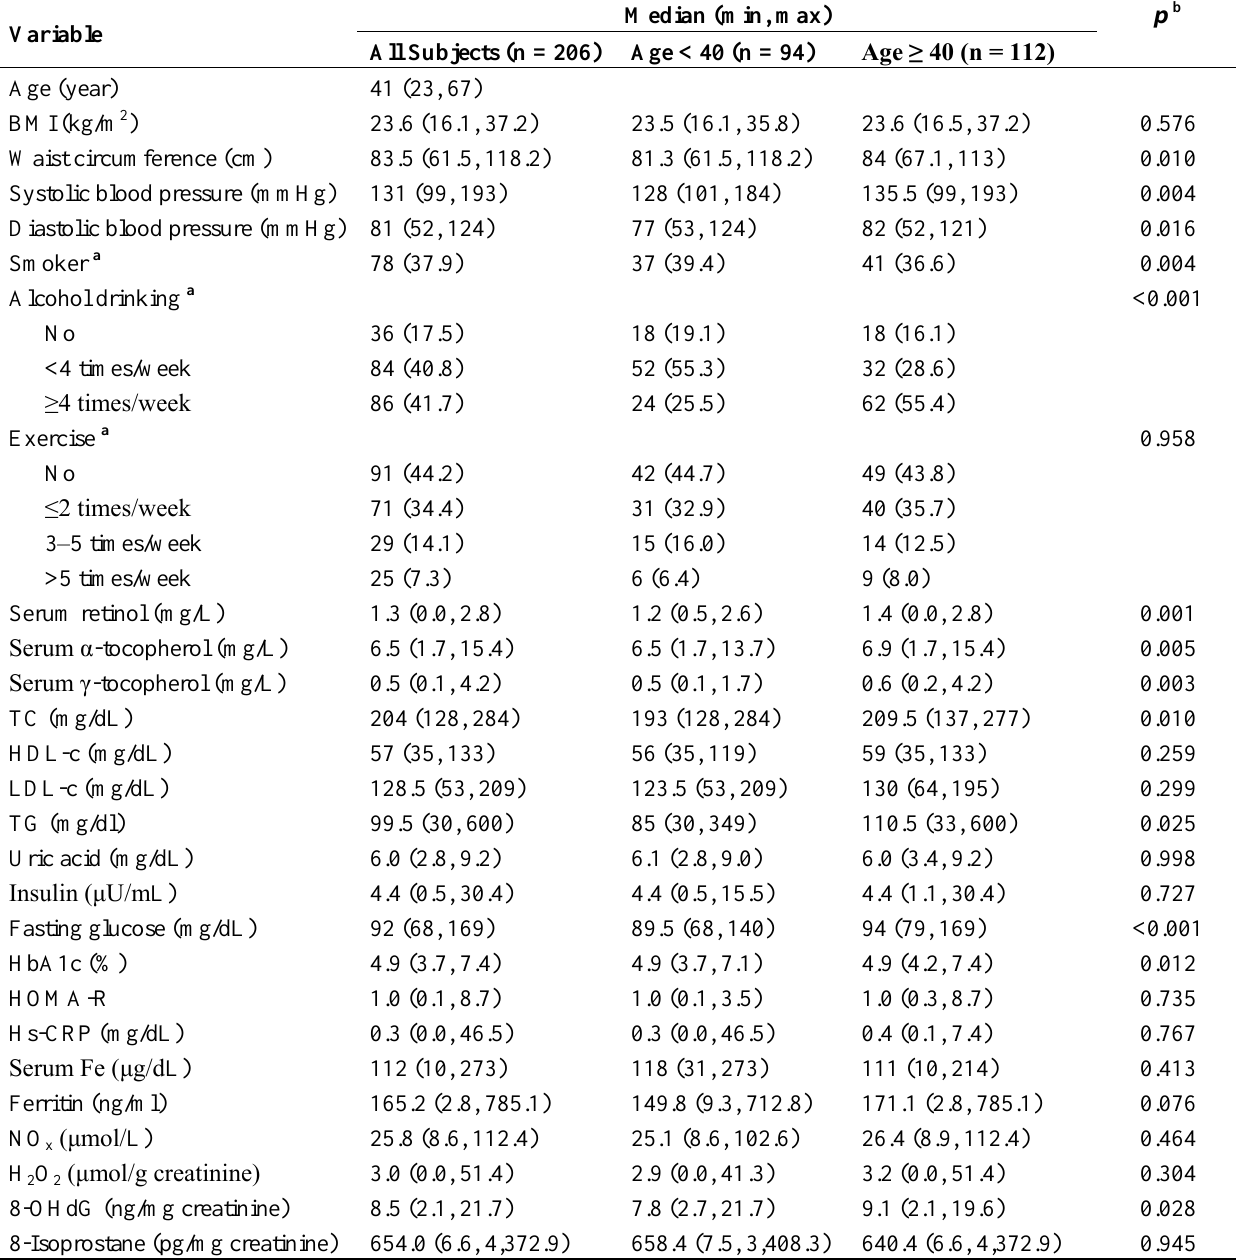
Table 1. Characteristics and clinical profile of